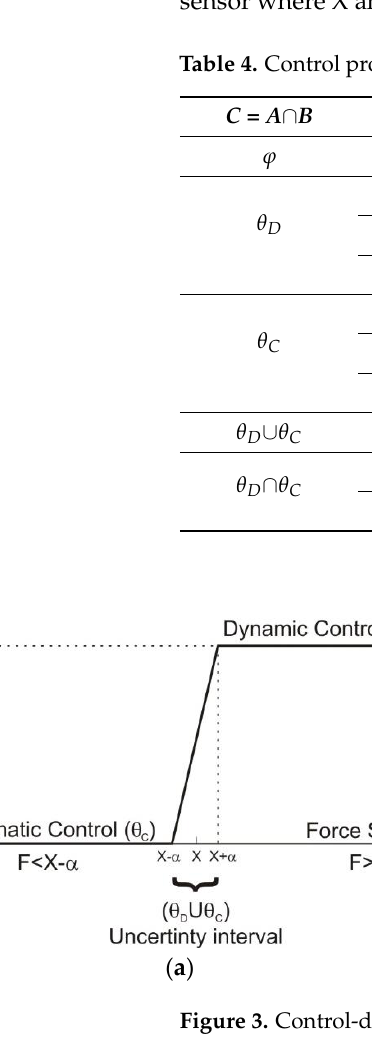
Table 3. The experimental data after using Equation (6).